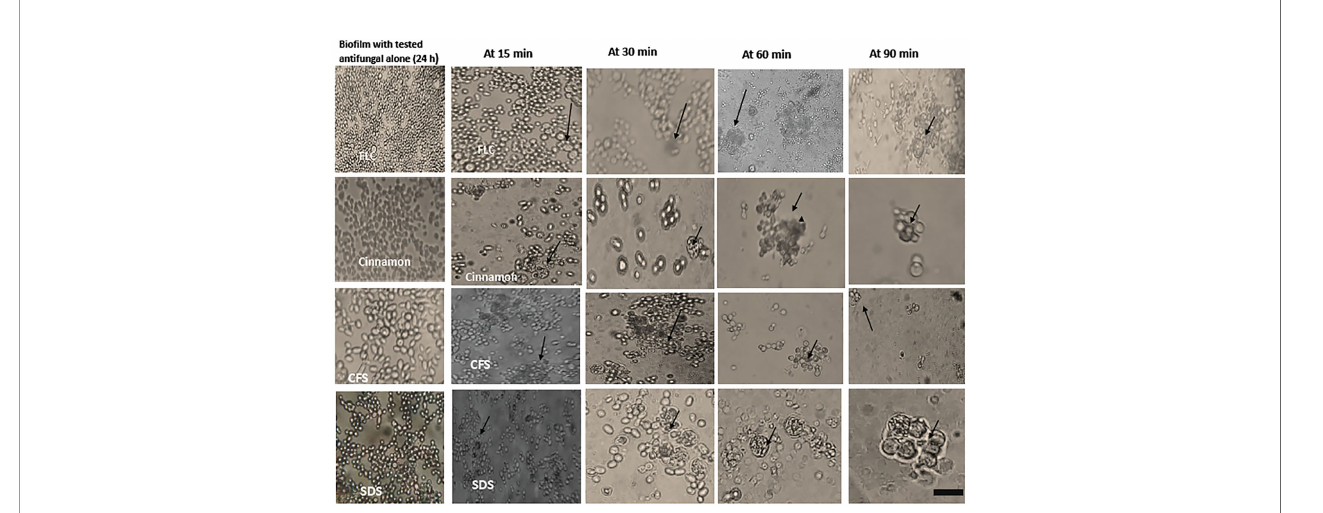
FIGURE 4 | Interaction between peripheral blood leukocytes (PBLCs) and C. albicans bio fi lms alone or in combination with fl uconazole (1,024 µg/ml), cinnamon oil (4 µg/ml), E. faecalis – CFS (2 µg/ml), and sodium dodecyl sulfate (SDS; 2.5%) at different time intervals. Bio fi lm treated with cinnamon, E. faecalis – CSF, and SDS were effectively cleared within 60 min of PBLCs addition. Meanwhile, the cells were not eradicated after 90 min in fl uconazole-treated bio fi lm (×400, scale bar = 40 µm). Arrows refer to PBLCs.